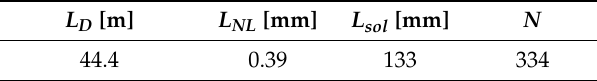
Figure 12. Numerical simulation of SG in the dispersion-optimized PCF, for pulse energy in the range of 0.2–3.6 nJ. For clarity characteristics are separated vertically by 20 dB. Table 6. Parameters of SG for the dispersion-optimized PCF.